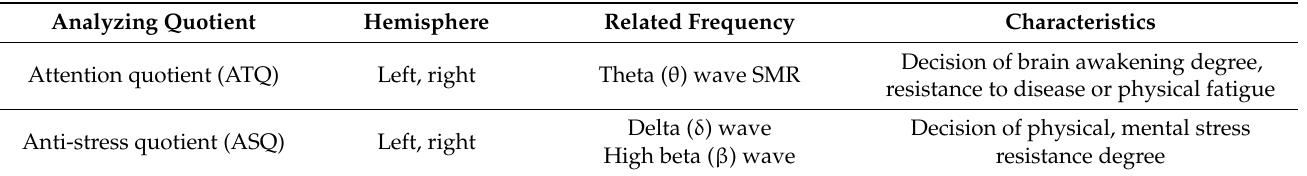
Table 2. The brain function